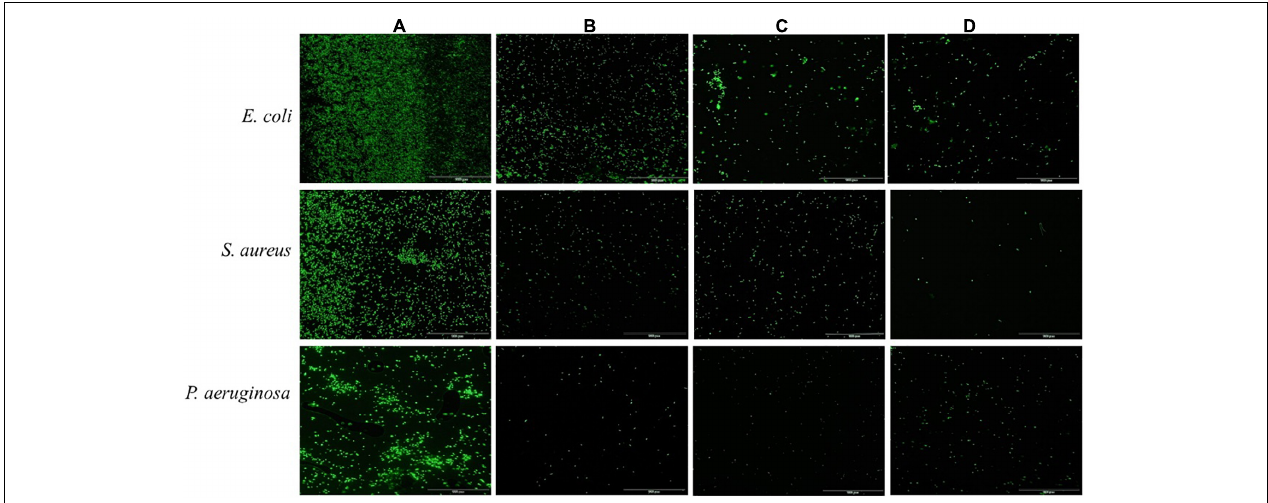
FIGURE 3 | Effects of ethyl acetate extracts from endophytic fungi on cell membrane integrity of E. coli , S. aureus, and P. aeruginosa by fluorescence microscope. (A) Untreated bacterial cells; (B) bacterial cells treated with P. oxalicum extracts at 2MIC; (C) bacterial cells treated with Simplicillium sp. extracts at 2MIC; (D) bacterial cells treated with Colletotrichum sp. extracts at 2MIC. The scale bar was 100 µ